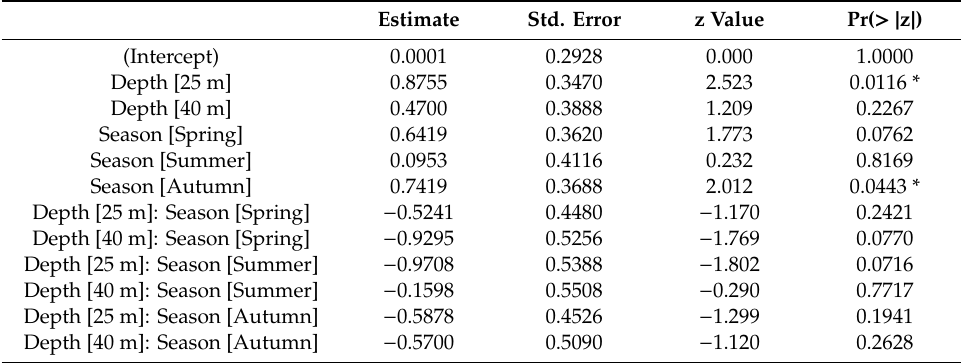
Figure 3. Richness (+SE of means) of brachyuran species at different depths (18, 25, and 40 m) and seasons (W: winter, Sp: spring, Sm: summer, Au: autumn) in 2015–2016 and 2017. Table 2. Summary of the mixed-effects GLM testing the effects of the fixed factors “Depth” (18, 25, and 40 m) and “Season” on the richness of brachyuran species. The contribution of “Year” is not presented, as this was a random source of variation. Reference values were 18 m for “Depth” and winter for “Season”.